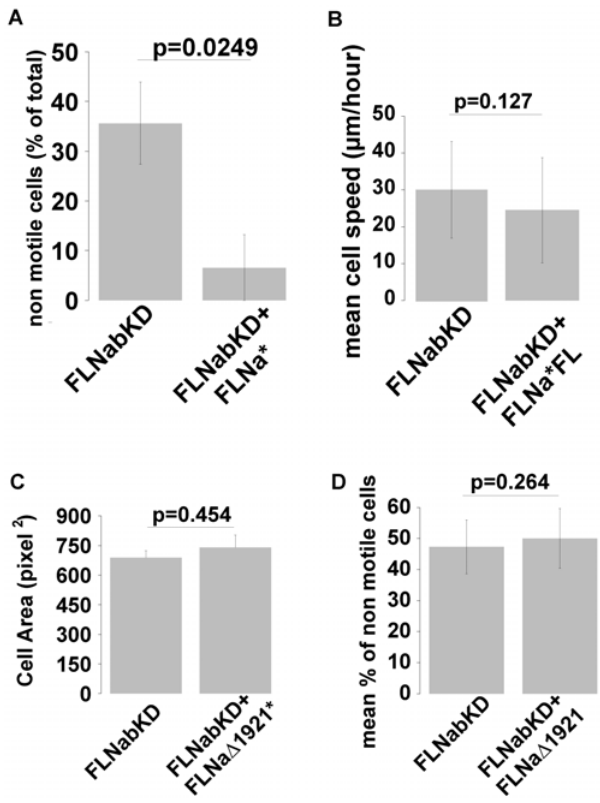
Figure 6. FLNa* but not FLNa* D 19–21 rescues motility of FLNabKD cells. A and B ) FLNabKD cells were transfected with FLNa*- GFP and assessed in time-lapse migration assays. Re-expressing cells were identified by staining for FLNa. Mean % of non-motile cells (A) and mean cell speed (B) in untransfected and FLNa-re-expressing FLNabKD cells. Values 6 SEM from at least 4 independent experiments: sample size FLNabKD=75; FLNabKD + FLNa*=9). C and D ) FLNabKD cells were transfected with FLNa D 19–21 and assessed in time-lapse